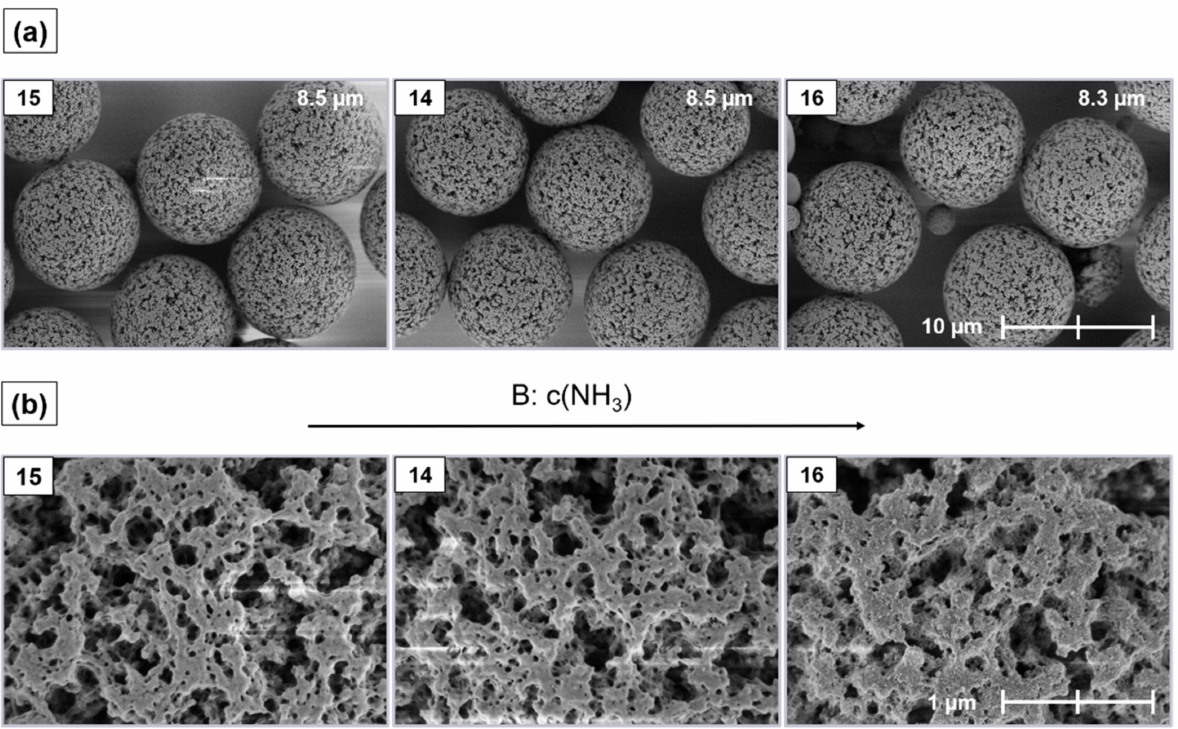
Figure A2. SEM image of the additional samples HB14–16 with n(H 2 O)/n(TEOS) = 8 sorted by increasing c(NH 3 ) (l.t.r.) at ( a ) 5000 × and ( b ) 50,000 ×